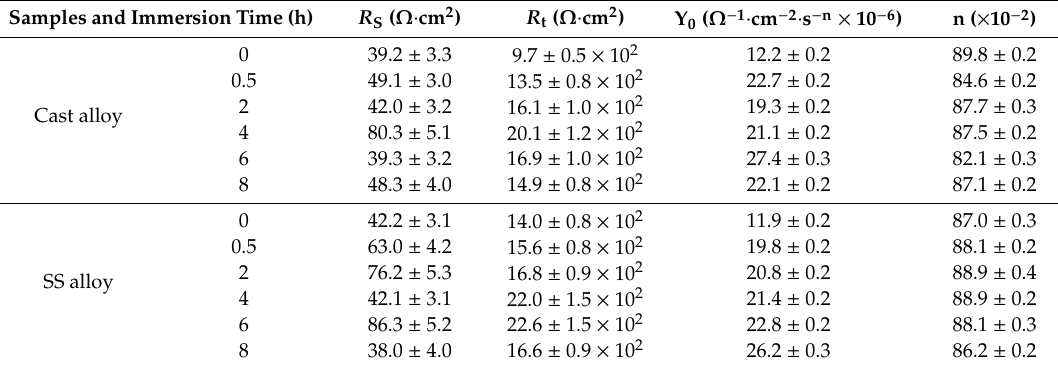
Figure 6. Electrochemical impendence spectroscopy (EIS) Nyquist plots of the cast alloy ( a ) and SS alloy ( b ) and the histogram of R t values ( c ). Table 3. Fitted EIS parameters of Mg-9Li alloys with a di ff erent exposure